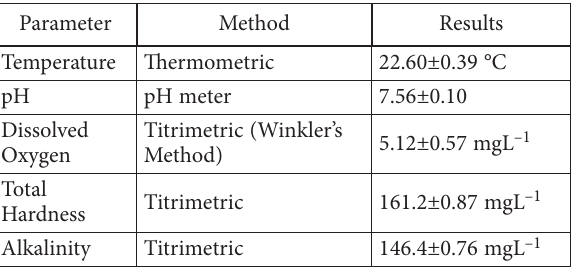
Table 2. Water quality parameters of the experimental tank